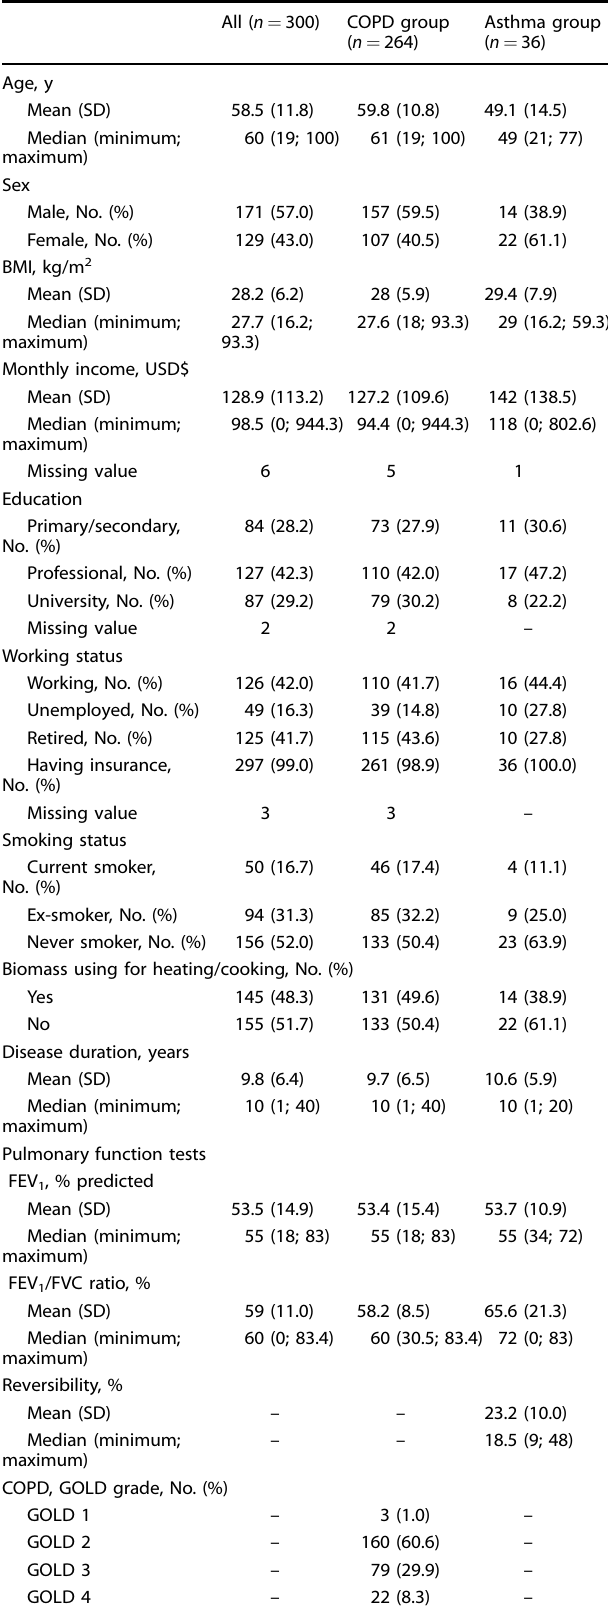
Table 1. Sociodemographic and clinical characteristics of asthma and/ or COPD participants ( n =